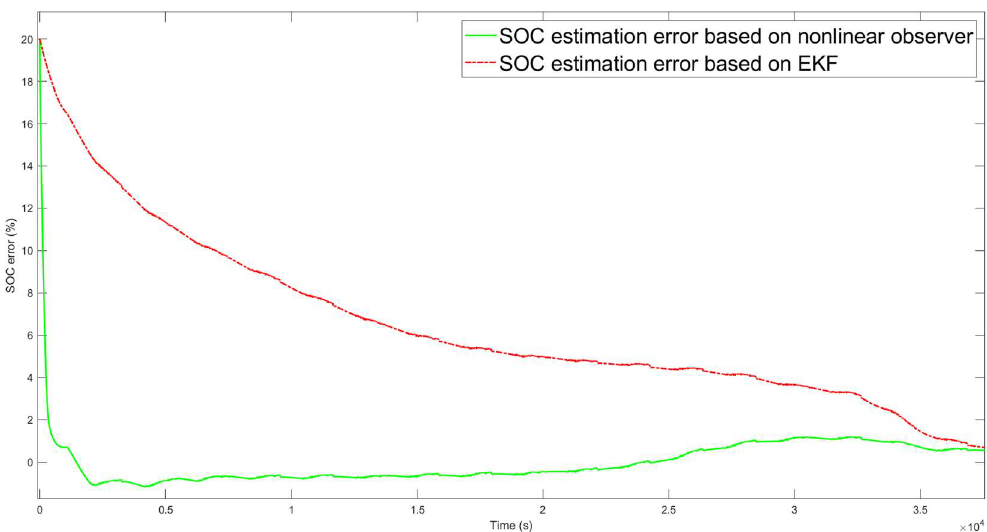
Figure 13. Comparison of SOC estimation based on non-linear observer and EKF in dynamic con- dition test 1 under random SOC initial value.